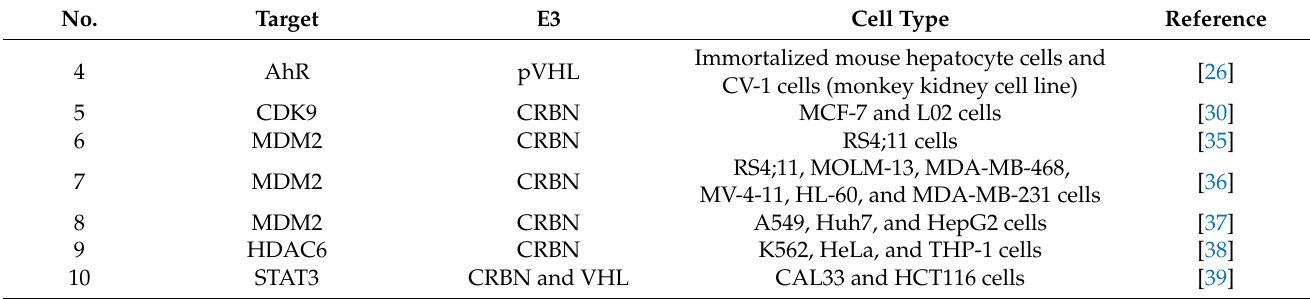
Table 4. Natural product targets 4–12.